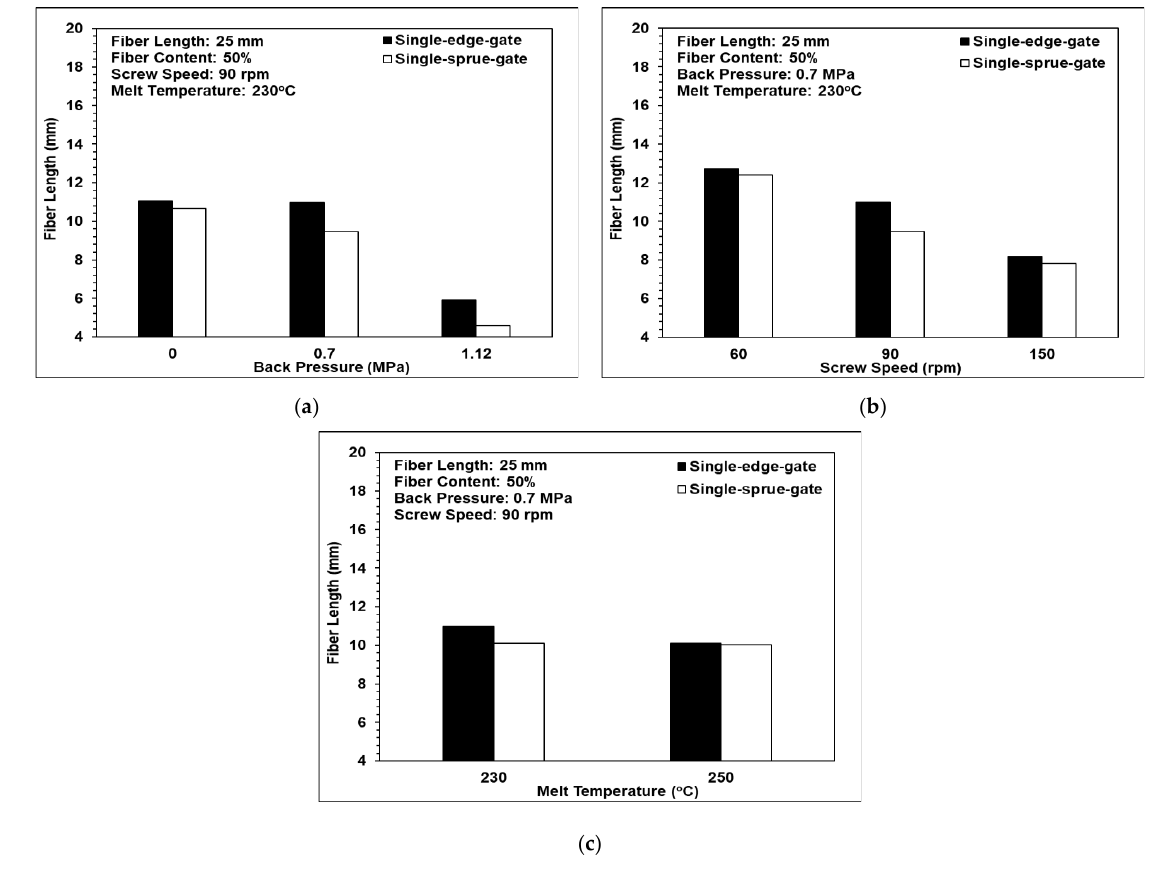
Figure 10. Effects of the different melt flow paths on fiber length: ( a ) back pressure variations, ( b ) screw speed variations, and ( c ) melt temperature variations.